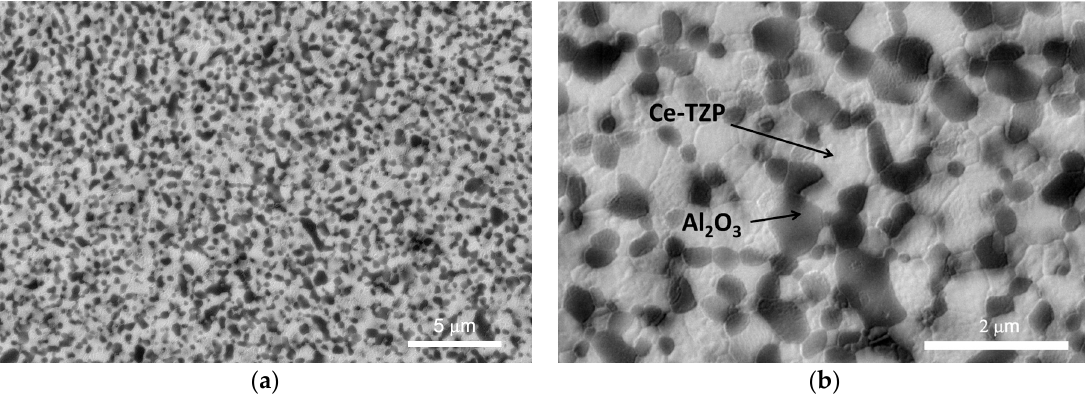
Figure 1. SEM micrographs of the ZCe-A nanocomposite at different magnification. ( a ) ×10000 and ( b ) ×40000.